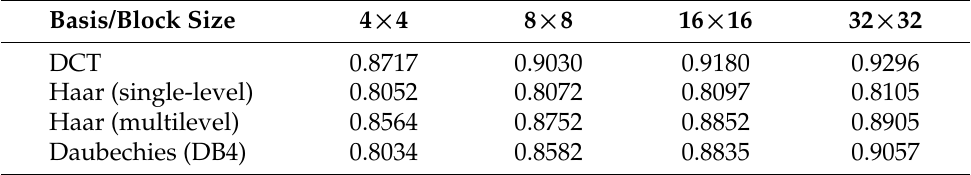
Table 1. Level of sparsity ( γ ) for different